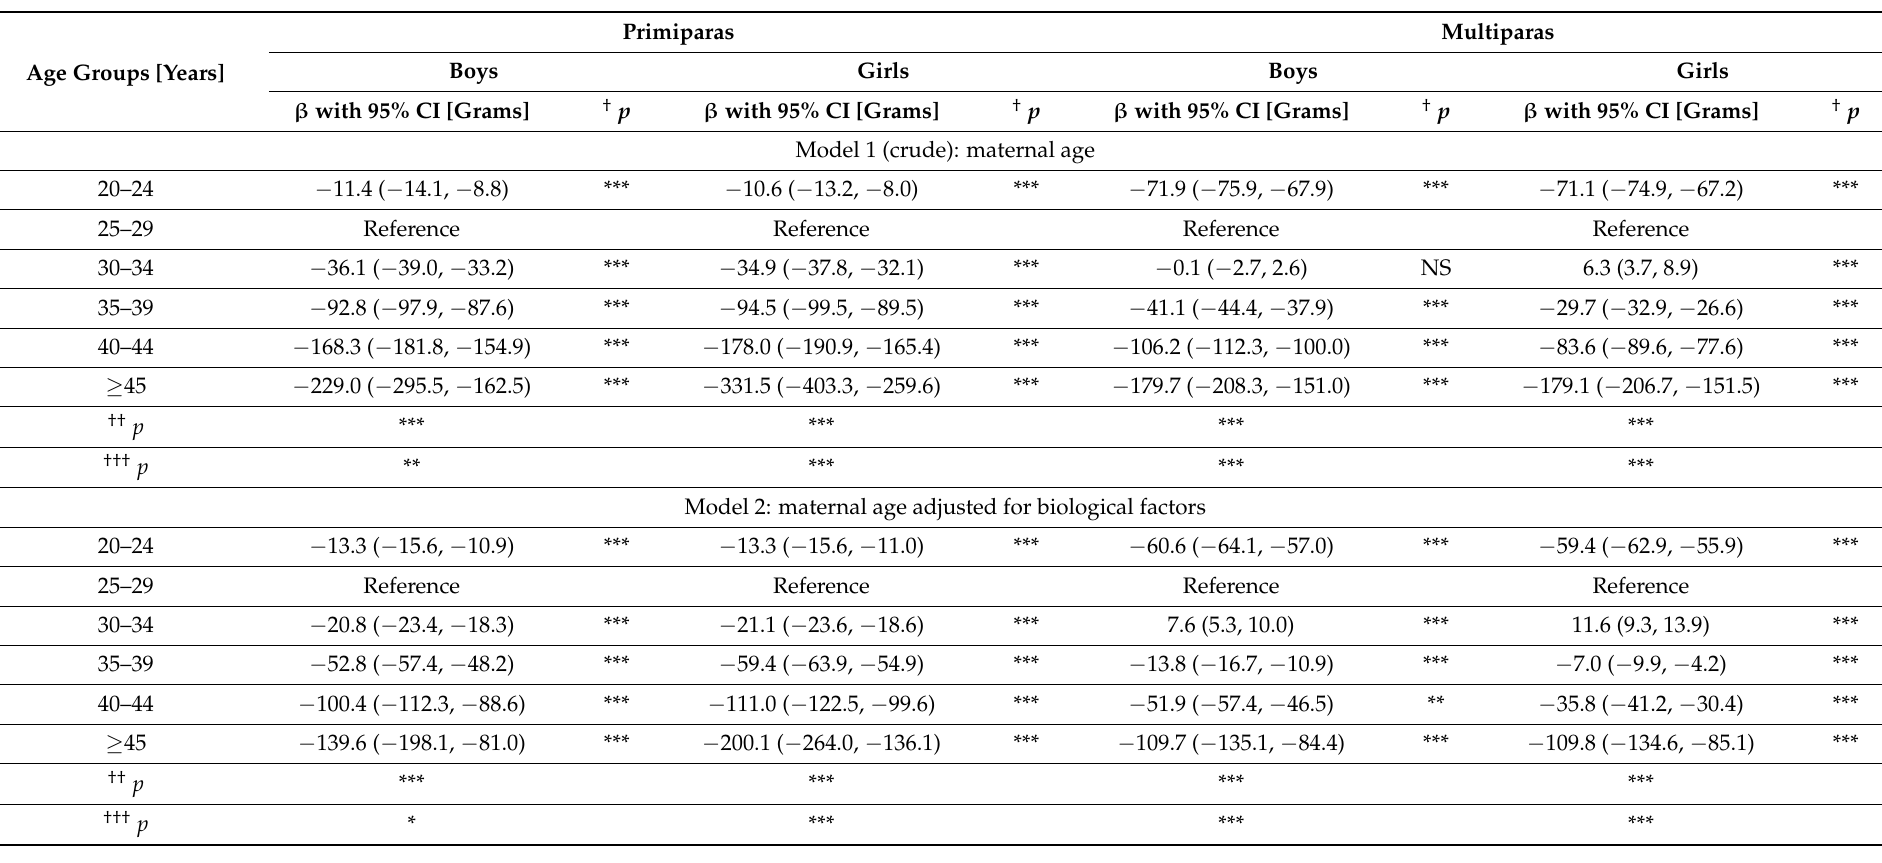
Table 3. Effects of maternal age ( β ) in regression models for birth weight stratified by parity and sex of